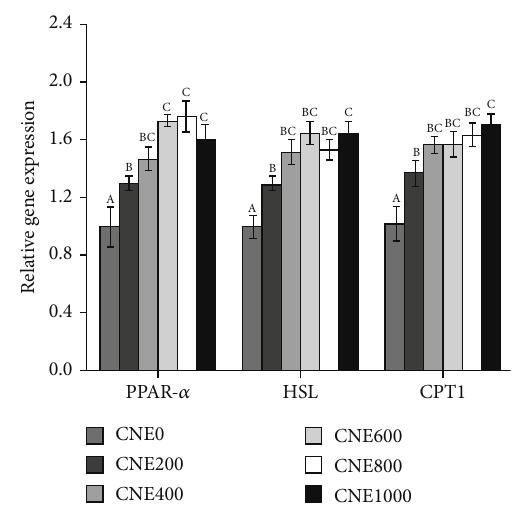
Figure 2: Relative gene expression of PPAR- α , HSL , and CPT1 in juvenile H . otakii -fed diets supplemented with CNE levels. Mean values for the same gene with di ff erent letters were signi fi cantly di ff erent ( P < 0 : 05